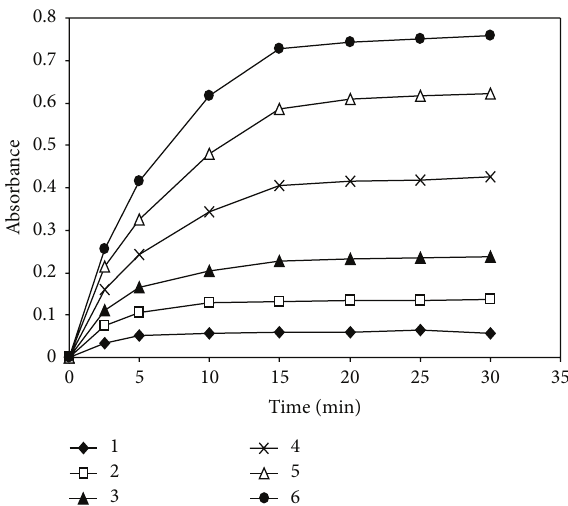
Figure 6: Absorbance versus time graphs for the reaction of MOX and NBD-Cl. Concentration of MOX: (1) 4.57 × 10 −6 , (2) 9.14 × 10 −6